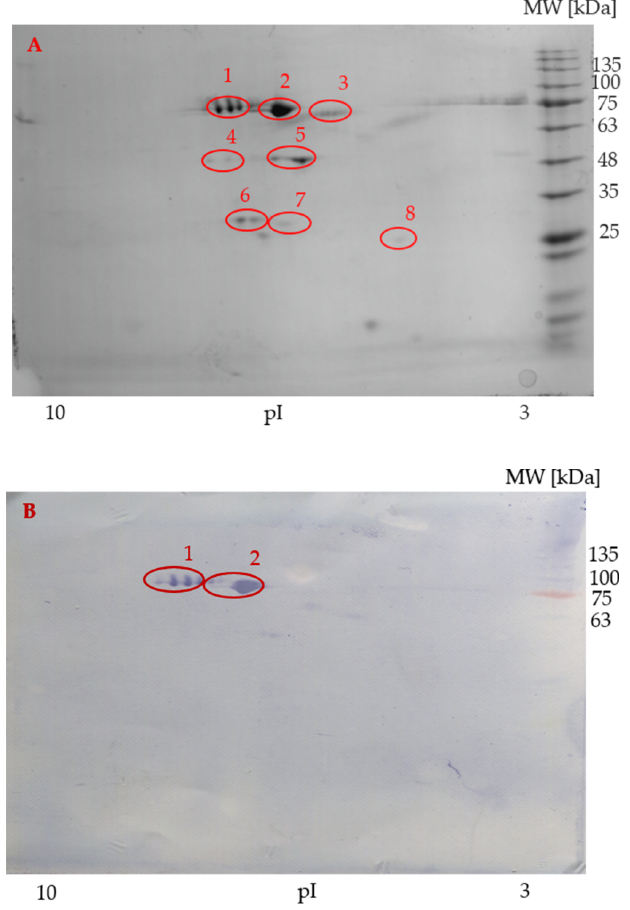
Figure 4. Representative sterlet seminal plasma protein profile ( A ) visualized by two-dimensional gel electrophoresis. Immunoblot of sterlet seminal plasma with specific antibodies ( B ). Circles show the identified protein spots, two of which were reactive and subjected to MALDI-TOF / TOF MS. Molecular weight marker is on the right. pI = Isoelectric points.